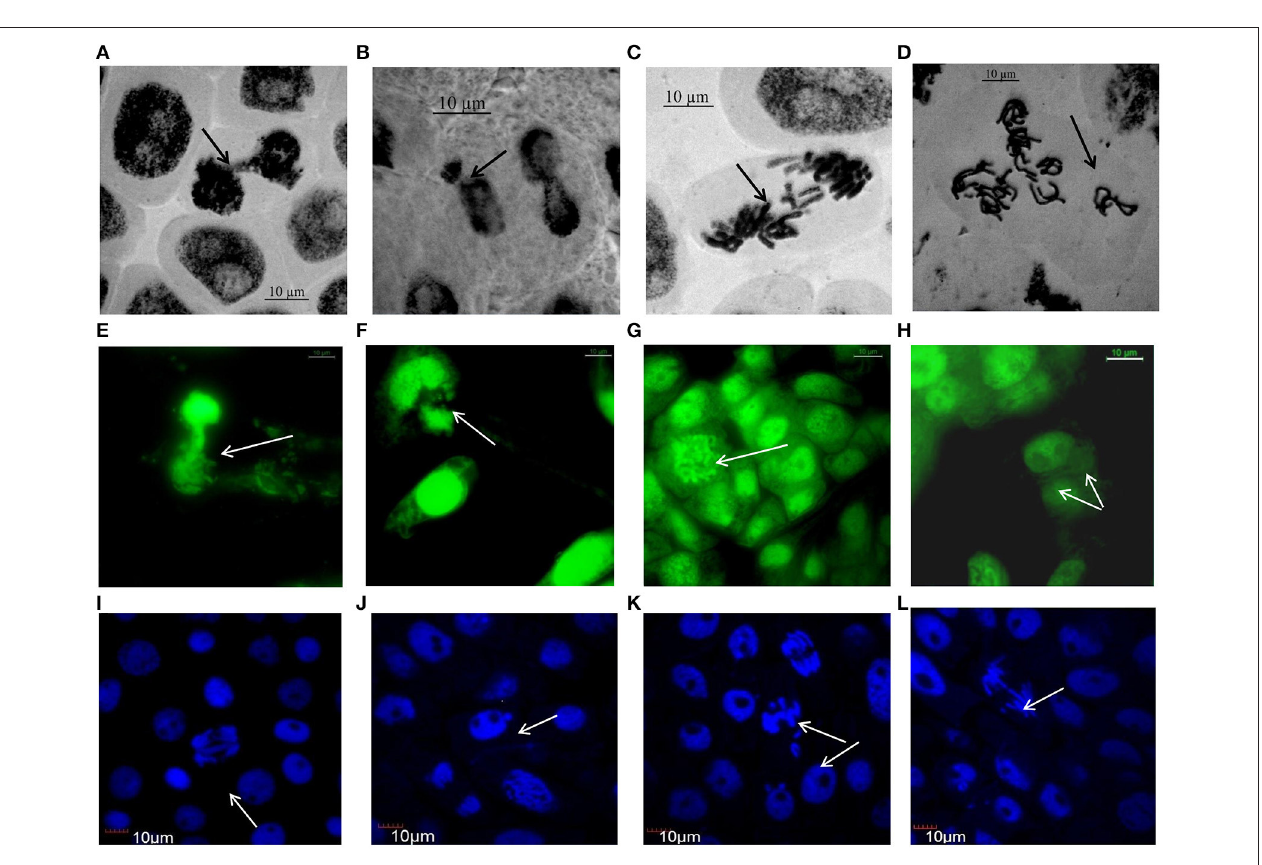
( Figure 5A ). In the present study, NiO-NP suspension at 10 mgL − 1 concentration was found to be sub lethal to A. sativum, A. fistulosum , and A. schoenoprasum while the concentration of 25 mgL − 1 was sublethal to the other two species namely, A. cepa and A. porrum . However, all concentrations from 50 mg L − 1 onwards were deemed to be lethal in all the